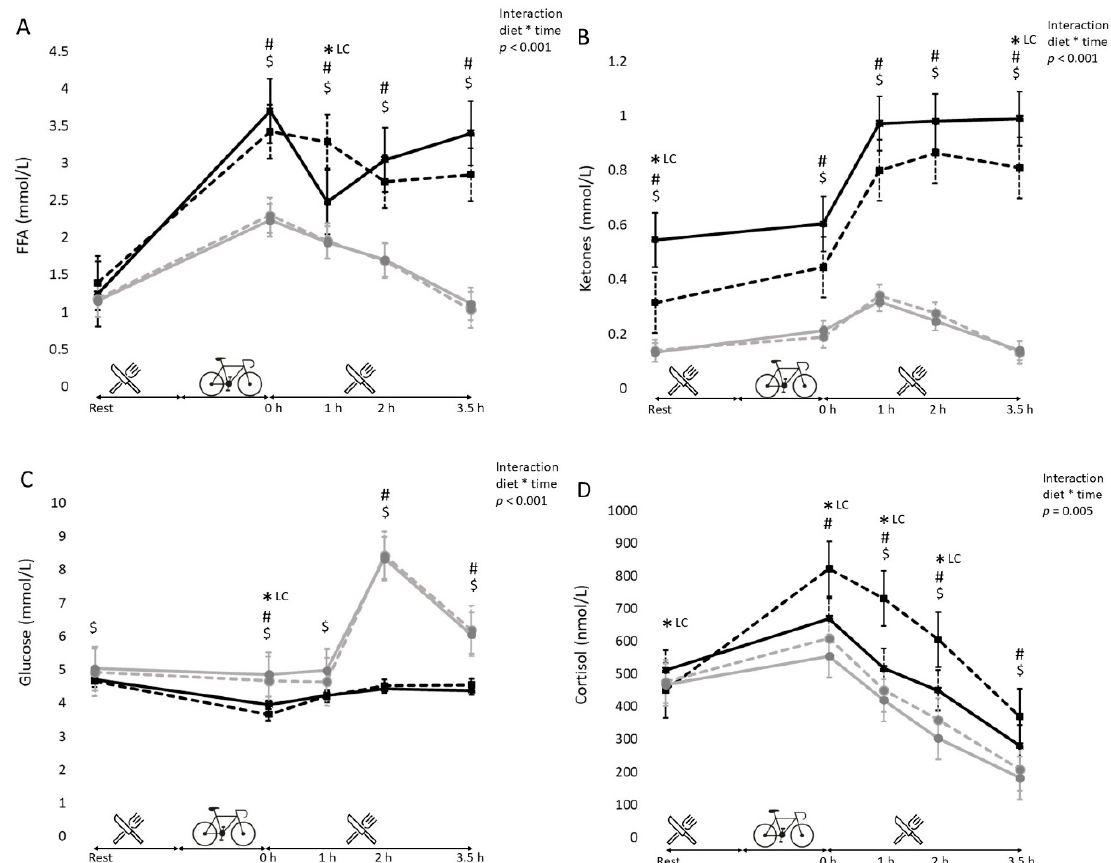
Figure 2. Metabolites. Circulating concentrations of Free fatty acids ( A ), Ketones ( B ), Glucose ( C ) and Cortisol ( D ) measured after 2 days on the LCHF diet (black dotted lines) and HC diet (grey dotted lines) and after 2 weeks on the LCHF diet (black continues line) and HC diet (grey continues line). Means ± SE are shown. All variables showed significant interactions (diet x time) effects. * LC indicates that this difference was between 2 days and 2 weeks on the LCHF diet. Within the HC diet there were no differences between concentrations after 2 days and 2 weeks on that diet. # indicates significant differences between the LCHF and HC diet after 2 days. $ indicates significant differences between the LCHF and HC diet after 2 weeks.